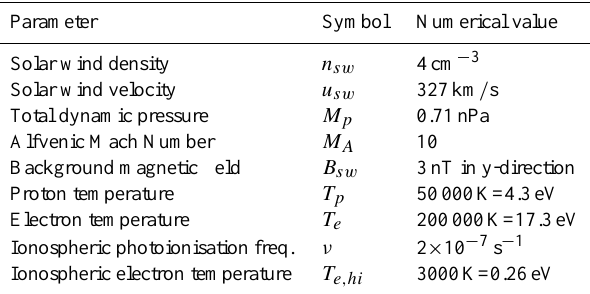
Table 1. Input parameters for simulation run 1.